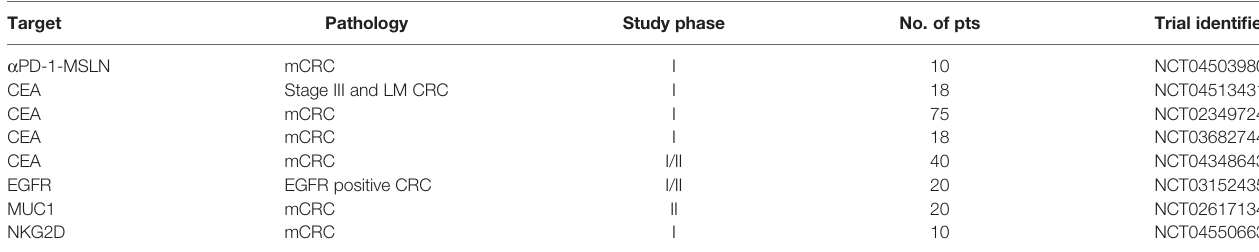
TABLE 2 | Ongoing clinical trials of CAR T-cell therapy in